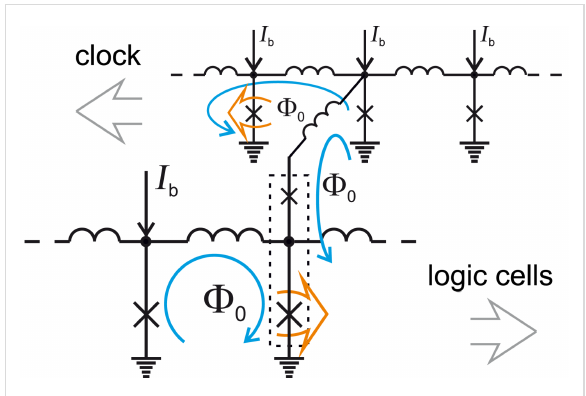
Figure 3: An RSFQ logic cell coupled to a clocking JTL. I b is the applied bias current. Blue arrows present circulating currents of SFQs. Orange arrows highlight Josephson junctions in the resistive state. The dotted rectangle marks the decision-making pair.